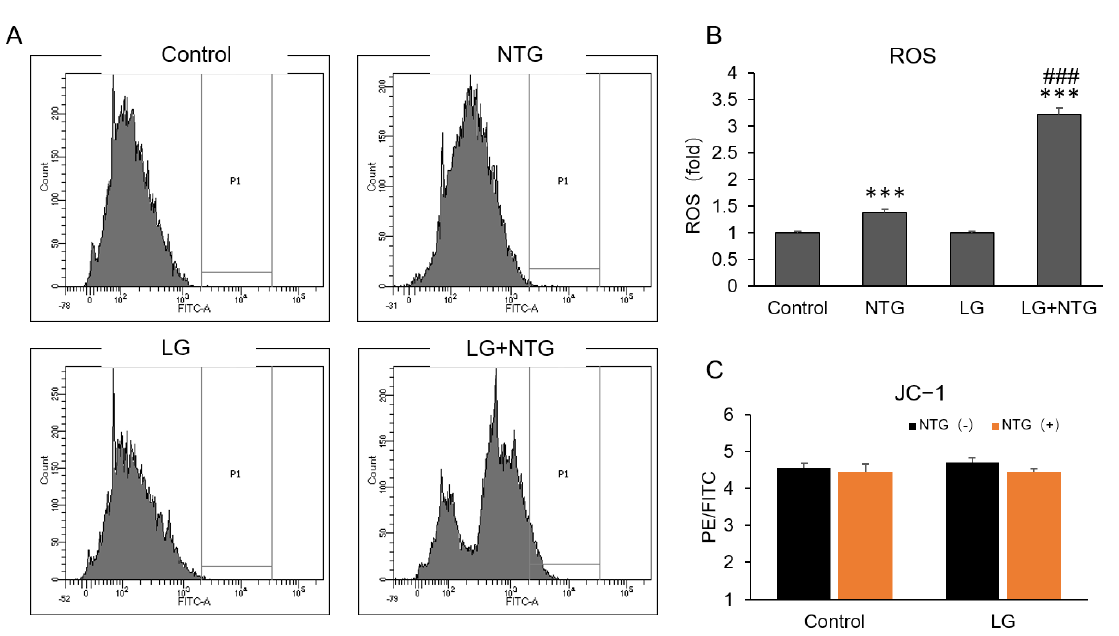
Figure 2. More ROS are induced by NTG in low-glucose condition in astrocytes. ( A ) ROS of astro- cytes were detected by flow cytometry after NTG treatment at a dose of 2 μg /mL for 1 h. Control, glucose 4.5 g/L; low glucose (LG, glucose 1 g/L). ( B ) Quantitative analysis showed that ROS level in low-glucose condition was about 2-fold compared with normal glucose after treated by NTG. ( C ) Mitochondrial membrane potential detected by JC − 1 showed no change in different conditions. ROS, reactive oxygen species ***, p < 0.001, compared with control; ###, p < 0.001, compared with NTG.